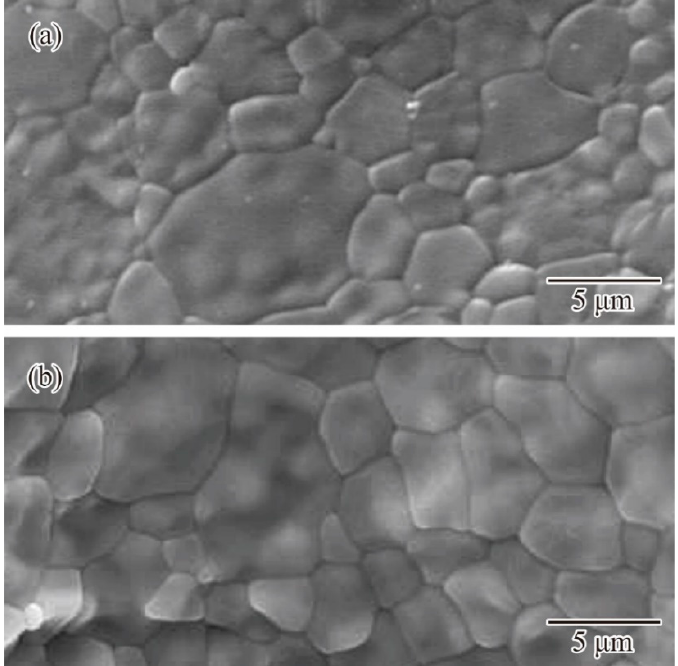
Figure 10. Ceramic microstructures in alumina crowns. Crystal grains observed by the scanning electron microscopy (SEM). Cross sections of the ( a ) horizontal and ( b ) vertical planes are defined as the parallel and vertical views of the laminated layers.